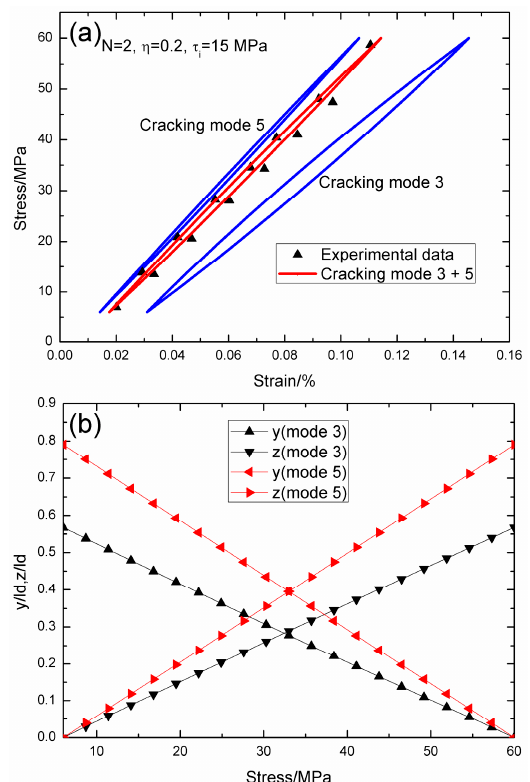
Figure 2. ( a ) The theoretical and experimental hysteresis loops; and ( b ) the interface slip lengths, i.e. , y / l d and z / l d , of matrix cracking modes 3 and 5 of 2D woven SiC/SiC composite under σ max = 60 MPa at 1000 °C in steam and a loading frequency of 1.0 Hz when N = 2.